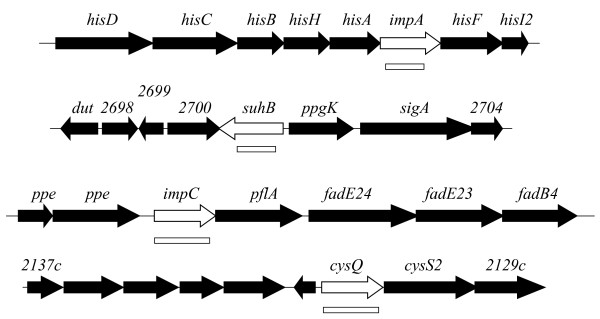
Genomic context of M. tuberculosis IMPase genes. White arrows: imp genes; black arrows: other genes; open rectangles deleted regions in knock out plasmids.